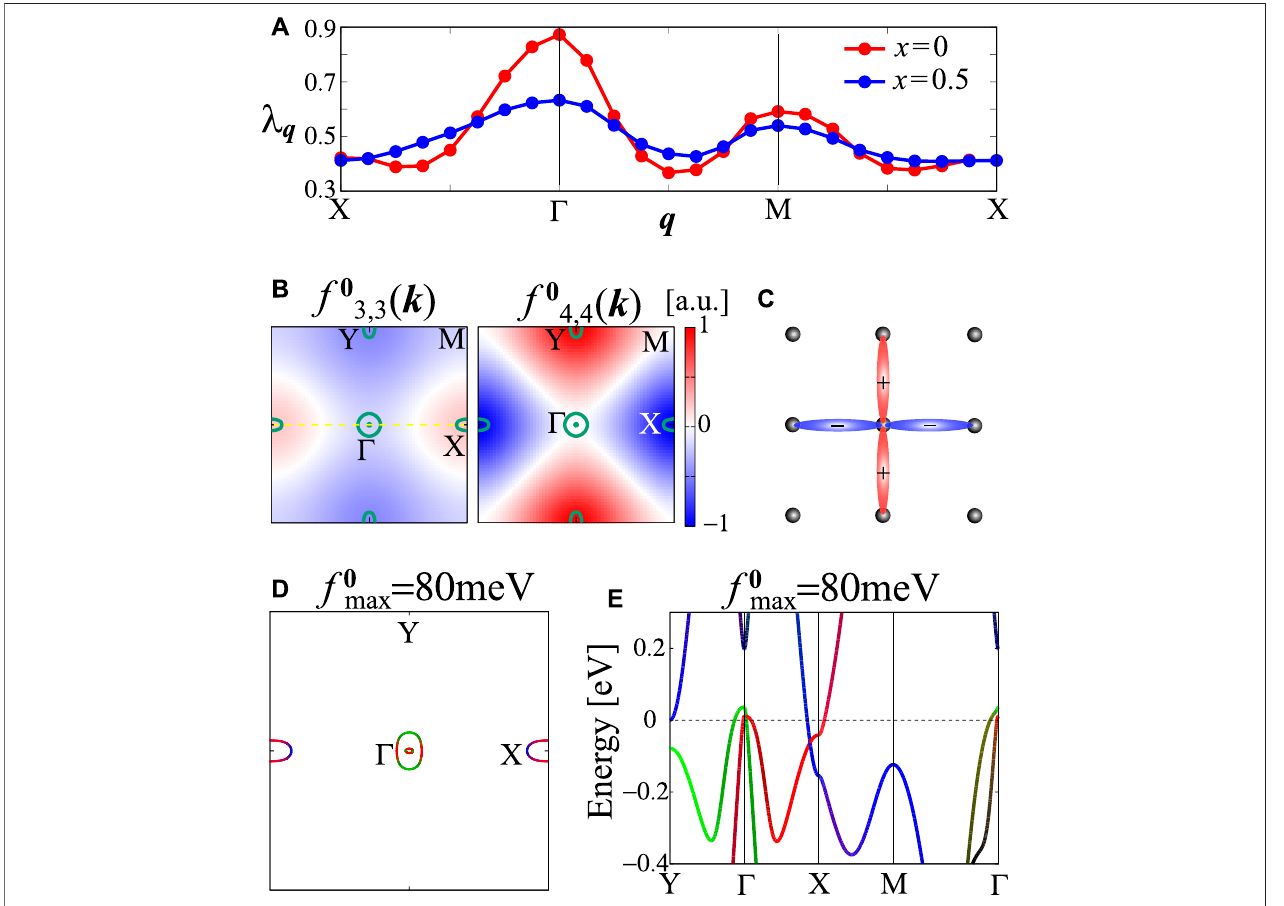
FIGURE 8 | (A) q dependences of λ q with self-energy for x = 0, 0.5. (B) k dependences of f 0 3 , 3 ( k ) and f 0 4 , 4 ( k ) for x = 0, where green lines denote FSs. f 0 3 , 3 ( k ) changes sign along the k x axis (yellow dashed line). (C) B 1 g nearest-neighbor bond order corresponding to f 0 4 , 4 ( k ) . (D) FSs and (E) band structure under the nematic order with f 0 max (cid:2) 80meV for x = 0.